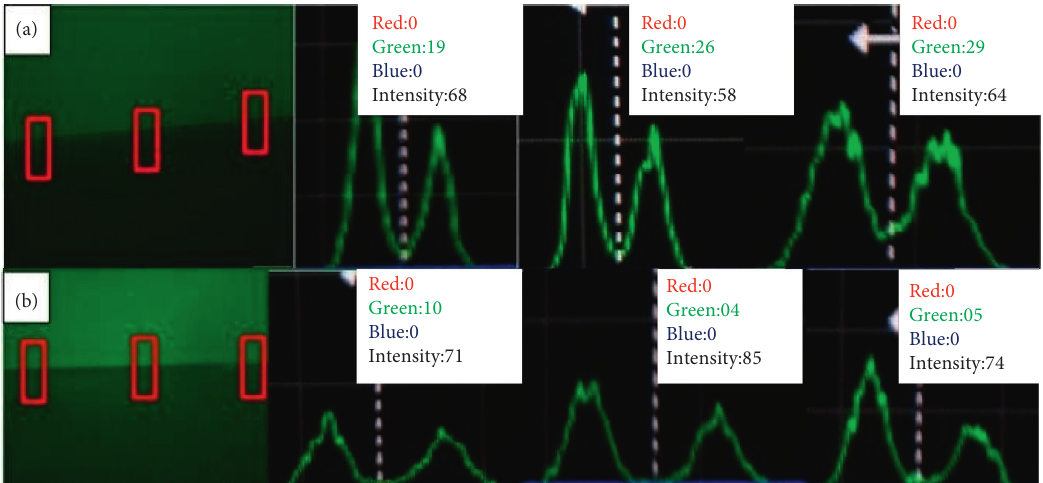
Figure 6: Histograms of MMP activity: (a) alkaline emulsion with Clearfil ™ and (b) alkaline emulsion with Adper Single Bond 2 ™